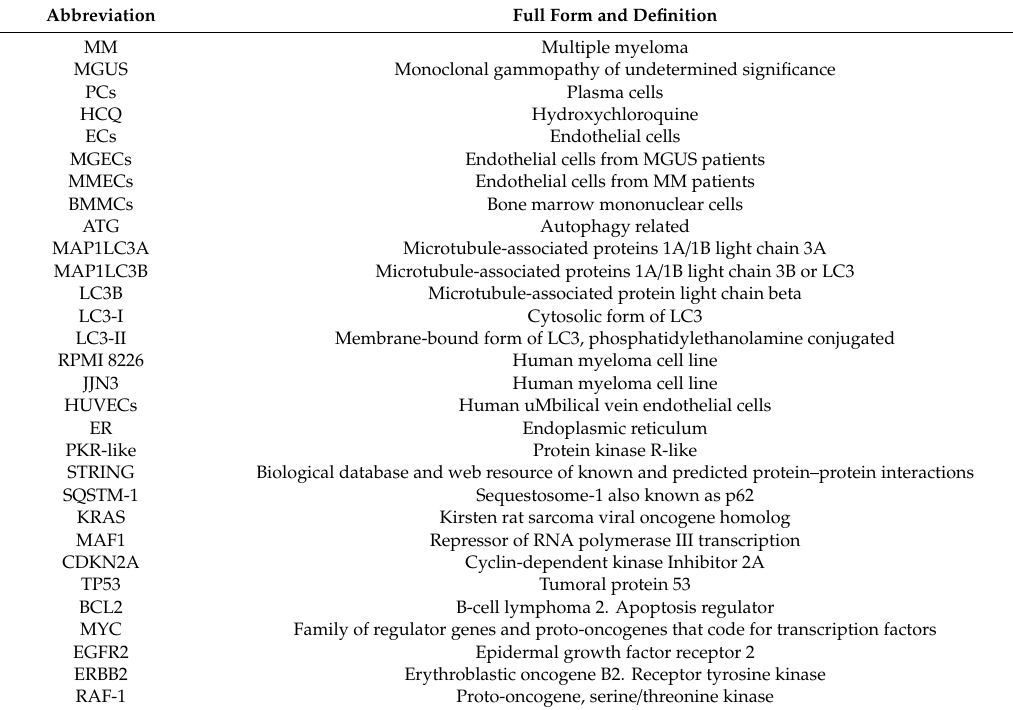
Table 1. Abbreviations and